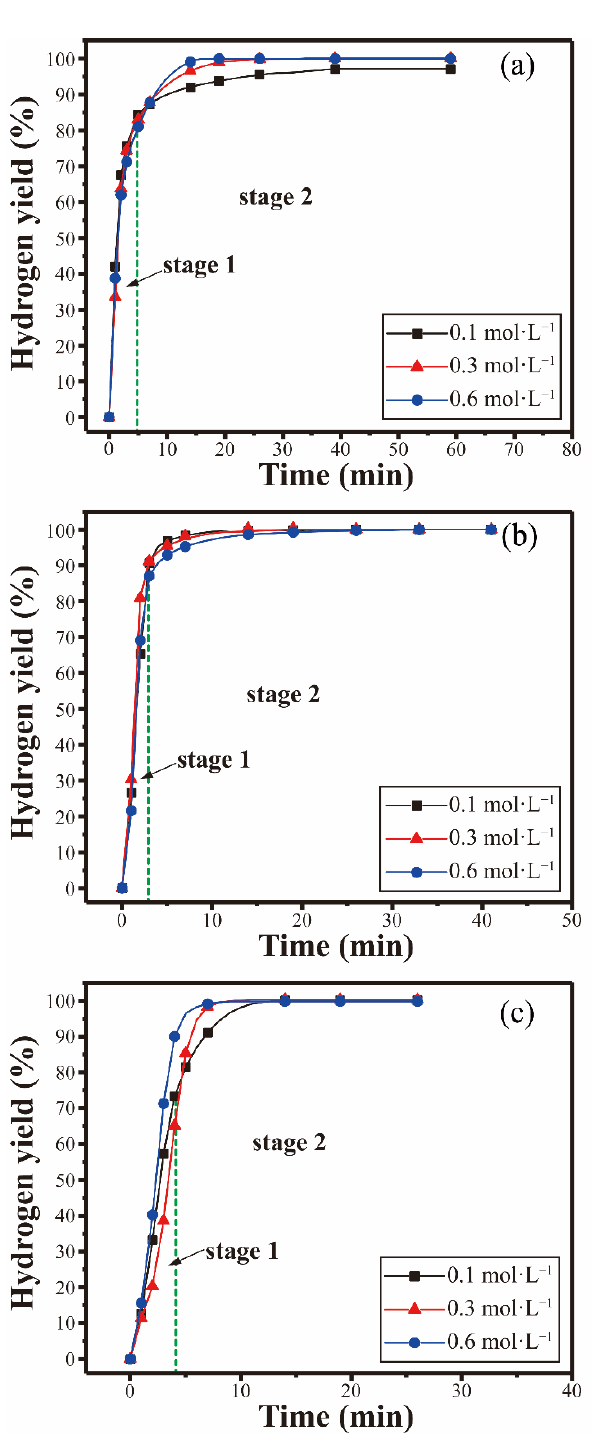
Figure 9. Hydrogen generation curves of the Al-Bi-Sn-Fe composite powders reacting with CaCl 2 solutions of different concentrations at 50 °C: ( a ) Al-10Bi-7Sn-0.5Fe (wt.%); ( b ) Al-10Bi-7Sn-1.5Fe (wt.%); ( c ) Al-10Bi-7Sn-3Fe (wt.%).